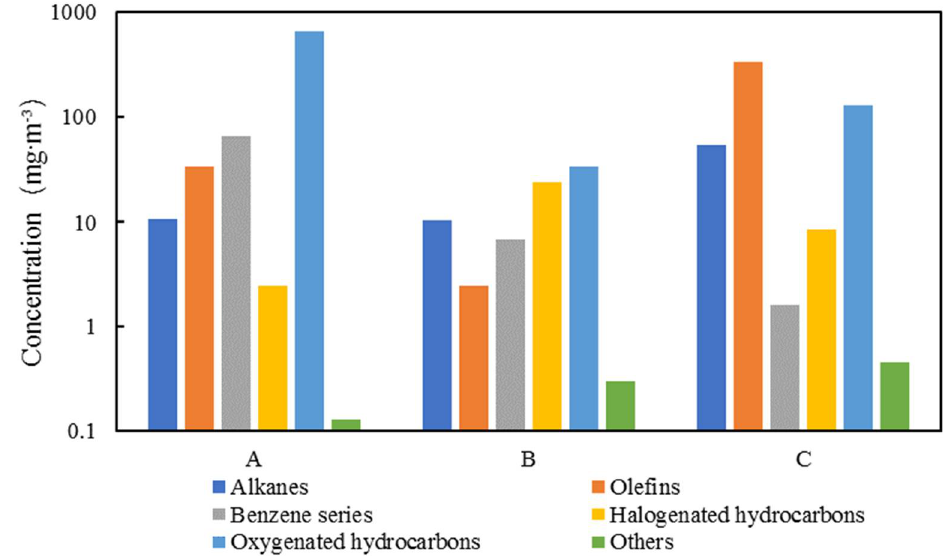
Figure 1. Concentrations of VOCs emitted from the three plants. Note: The standard deviation of alkanes, olefins, benzene series, halogenated hydrocarbons, oxygenated hydrocarbons and others are ±54.88 mg/m³, ±330.61 mg/m³, ±66.57 mg/m³, ±24.34 mg/m³, ±647.48 mg/m³ and ±0.46 mg/m³, respectively.